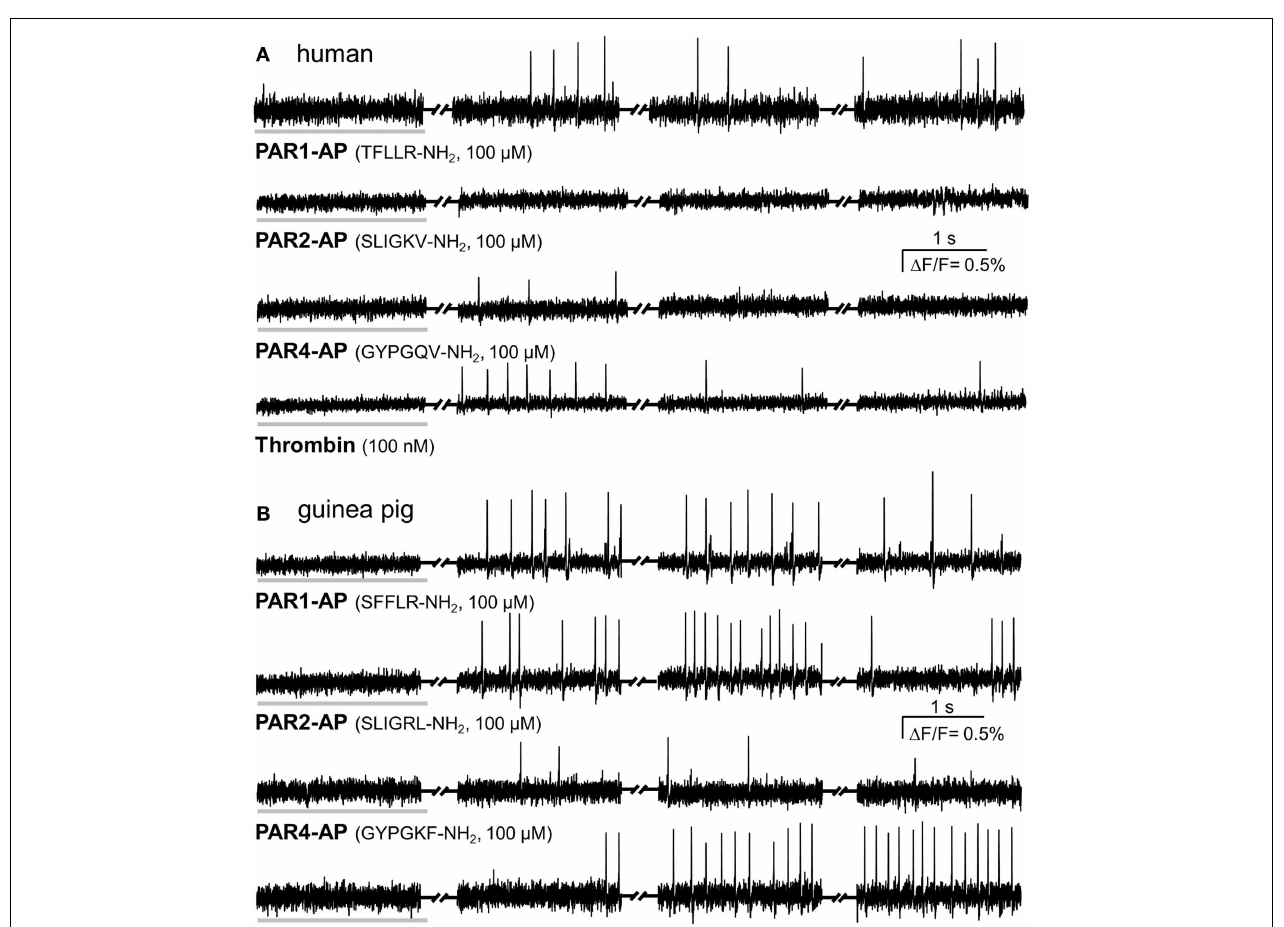
Representative traces from cultured human myenteric neurons to human specific PAR-APs and thrombin show comparable responses to PAR1-AP and thrombin but no response to PAR2-AP and a minor response to PAR4-AP. (B) Guinea pig cultured myenteric neurons fire action potentials in response to PAR1-AP, PAR2-AP, PAR4-AP, and thrombin; the PAR4 response is rather